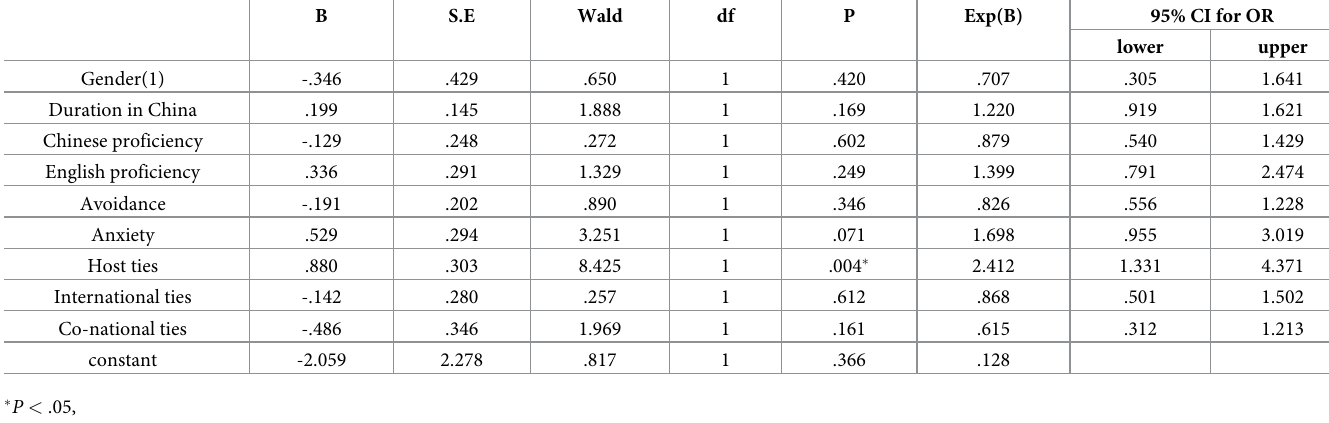
Table 4. Logistic regression predicting likelihood of adopting assimilation